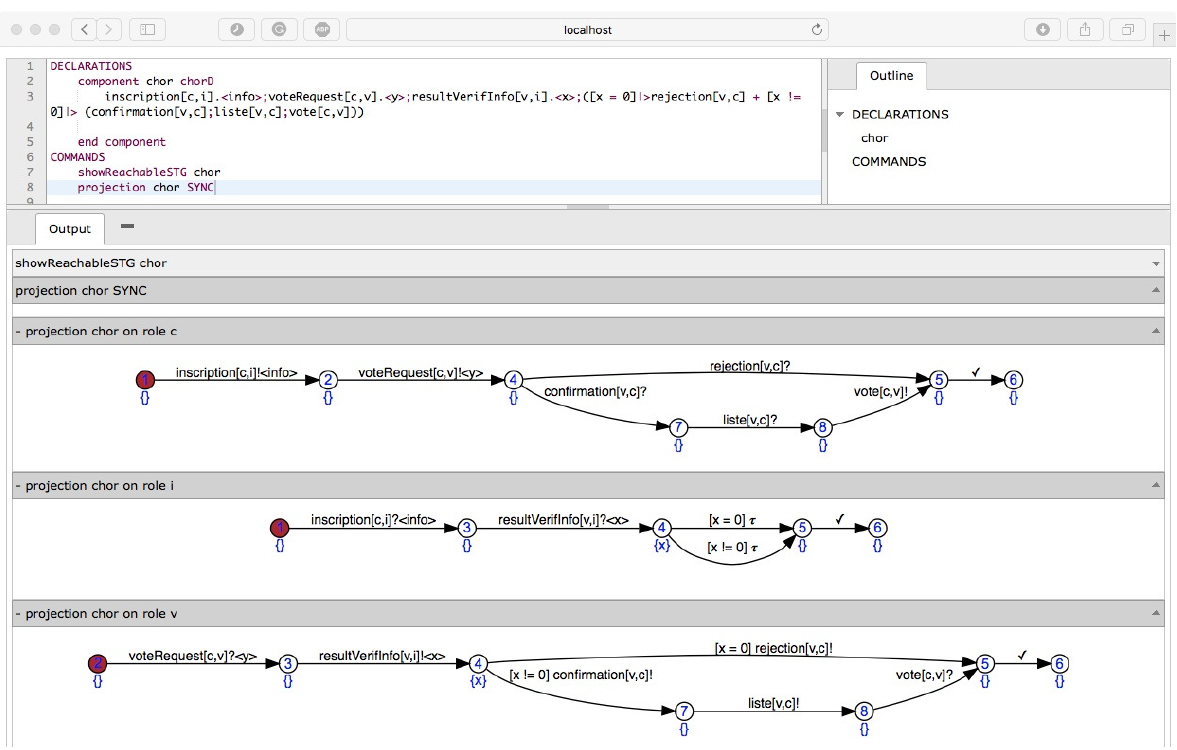
Figure 10. Verification of the vote